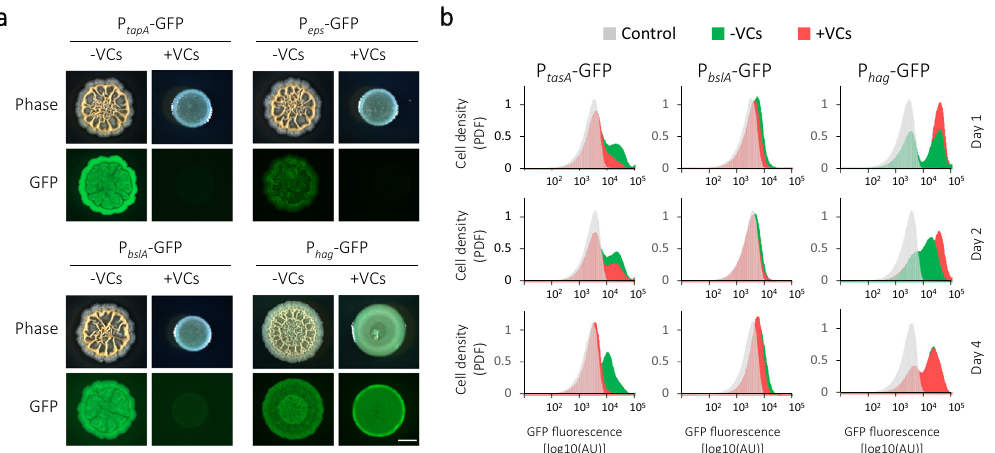
Fig. 2 Volatiles produced by B. subtilis bio fi lms inhibit ECM expression. a Top-down phase and fl uorescent (GFP) images of B. subtilis 3610 strains carrying P eps -GFP, P bslA -GFP, P tapA -GFP or P hag -GFP were incubated either alone ( − VCs) or in the presence of 20 volatile producers ( + VCs). Colonies were inoculated on solid B4 medium, and incubated for 2 days at 30 °C. Scale bar 2 mm. Images are representative of ( n > 3) independent experiments. b Flow cytometry analysis of colonies grown as in a for 1, 2 or 4 days, as indicated. Colonies were grown either alone (green, − VCs) or in the presence of 20 volatile producers (red, + VCs). Control (grey) — auto fl uorescence levels of the parental non- fl uorescent strain. Shown are representative results of three independent experiments performed with least two technical